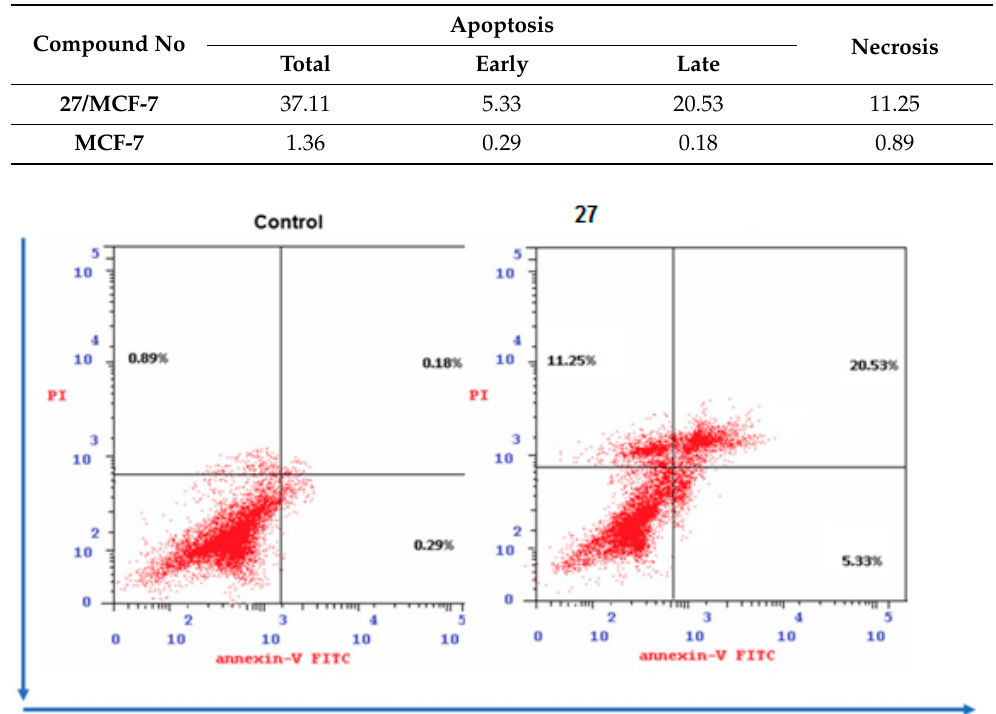
Figure 4. Evaluation of apoptosis induced by compound 27 treatment. Flow cytometry analysis for Annexin V-FITC/PI staining, Right : compound 27 -treated MCF-7 cells compared to Left : control MCF-7 cell.